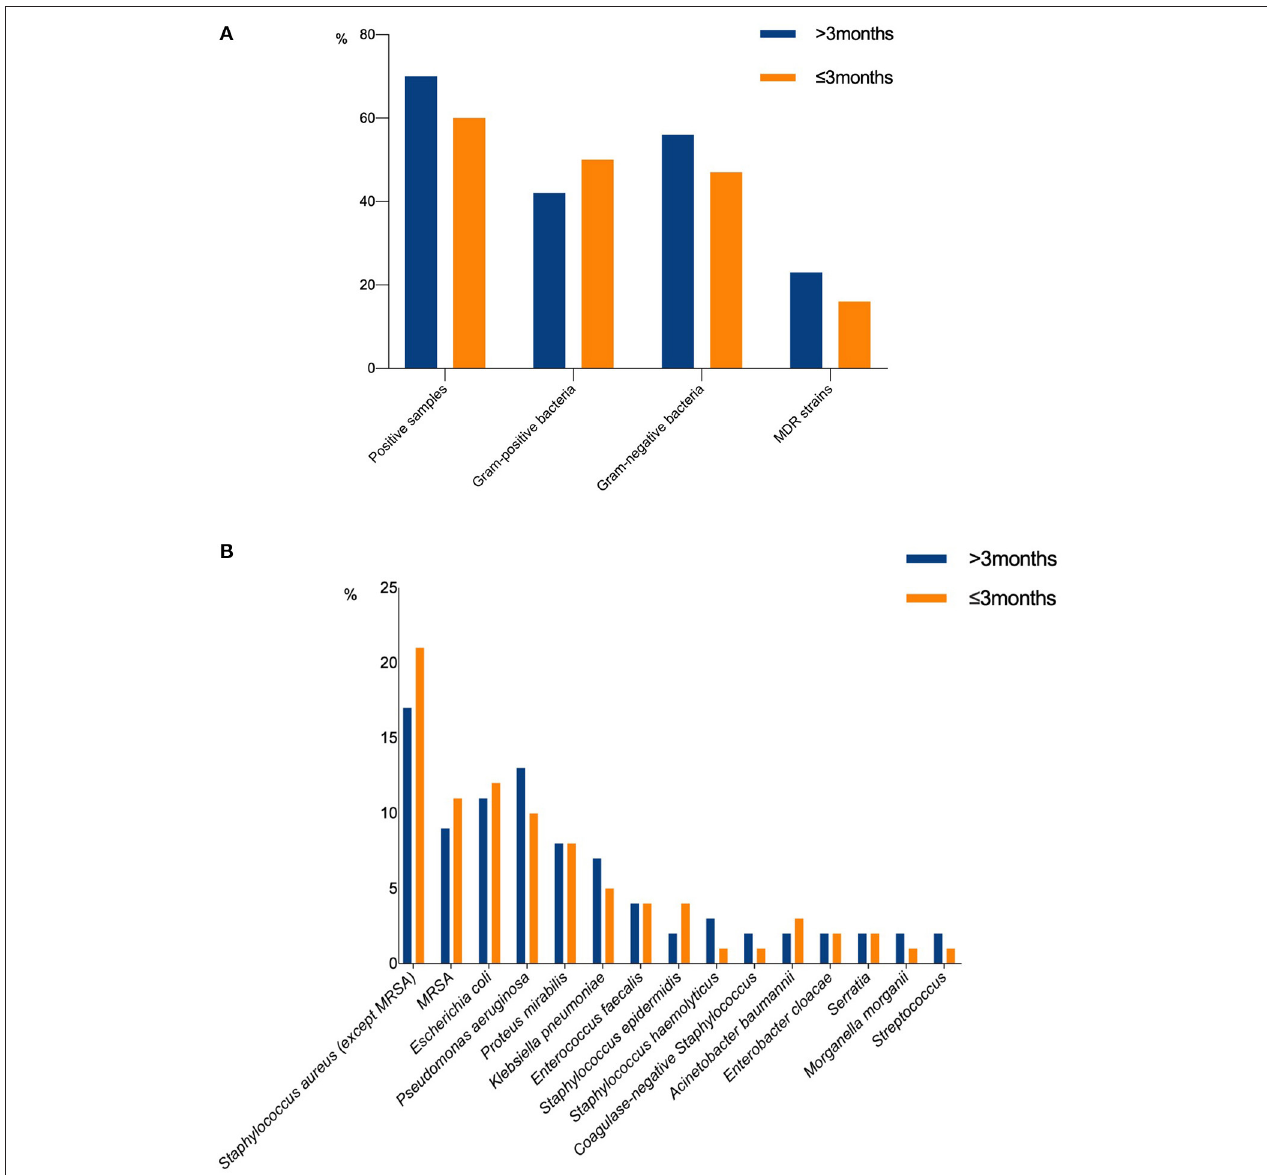
FIGURE 3 | (A, B) The distribution of pathogens in wounds of different